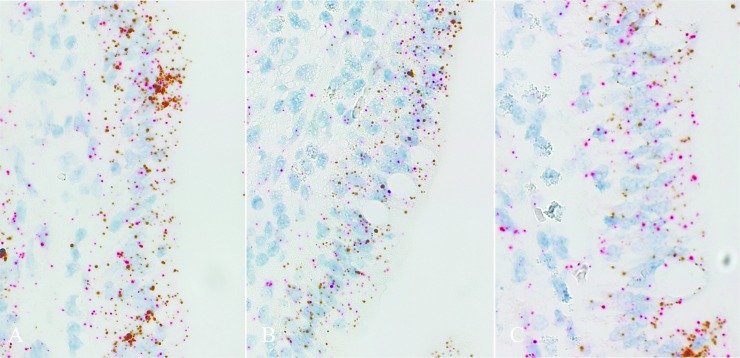
A-C. Representative RNAscope duplex for Occludin (brown) and ZO-1 (red). A) Pigs were either PRRSV naïve and fed ad libitum (Ad); B) PRRSV naïve and pair-fed to PRRS+ pigs intake (PF); or C) challenged with PRRSV (PRRS+).